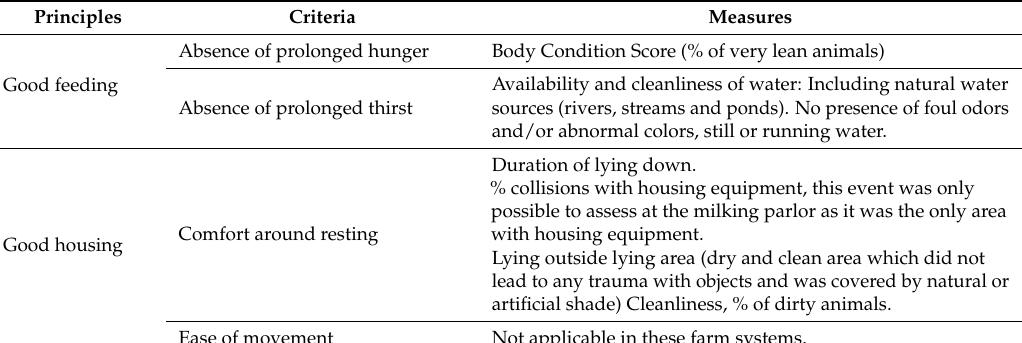
Table 1. Principles, criteria and measures of the Welfare Quality ® protocol used for the assessment. (Only a description of the adaptations for these tropical dual-purpose farms is provided below, the full protocol can be found at Reference